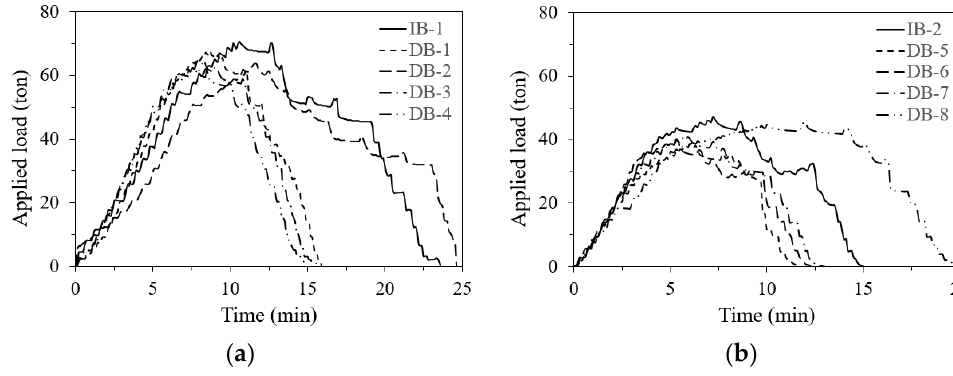
Figure 15. Loading and unloading histories: ( a ) Group A; ( b ) Group B.